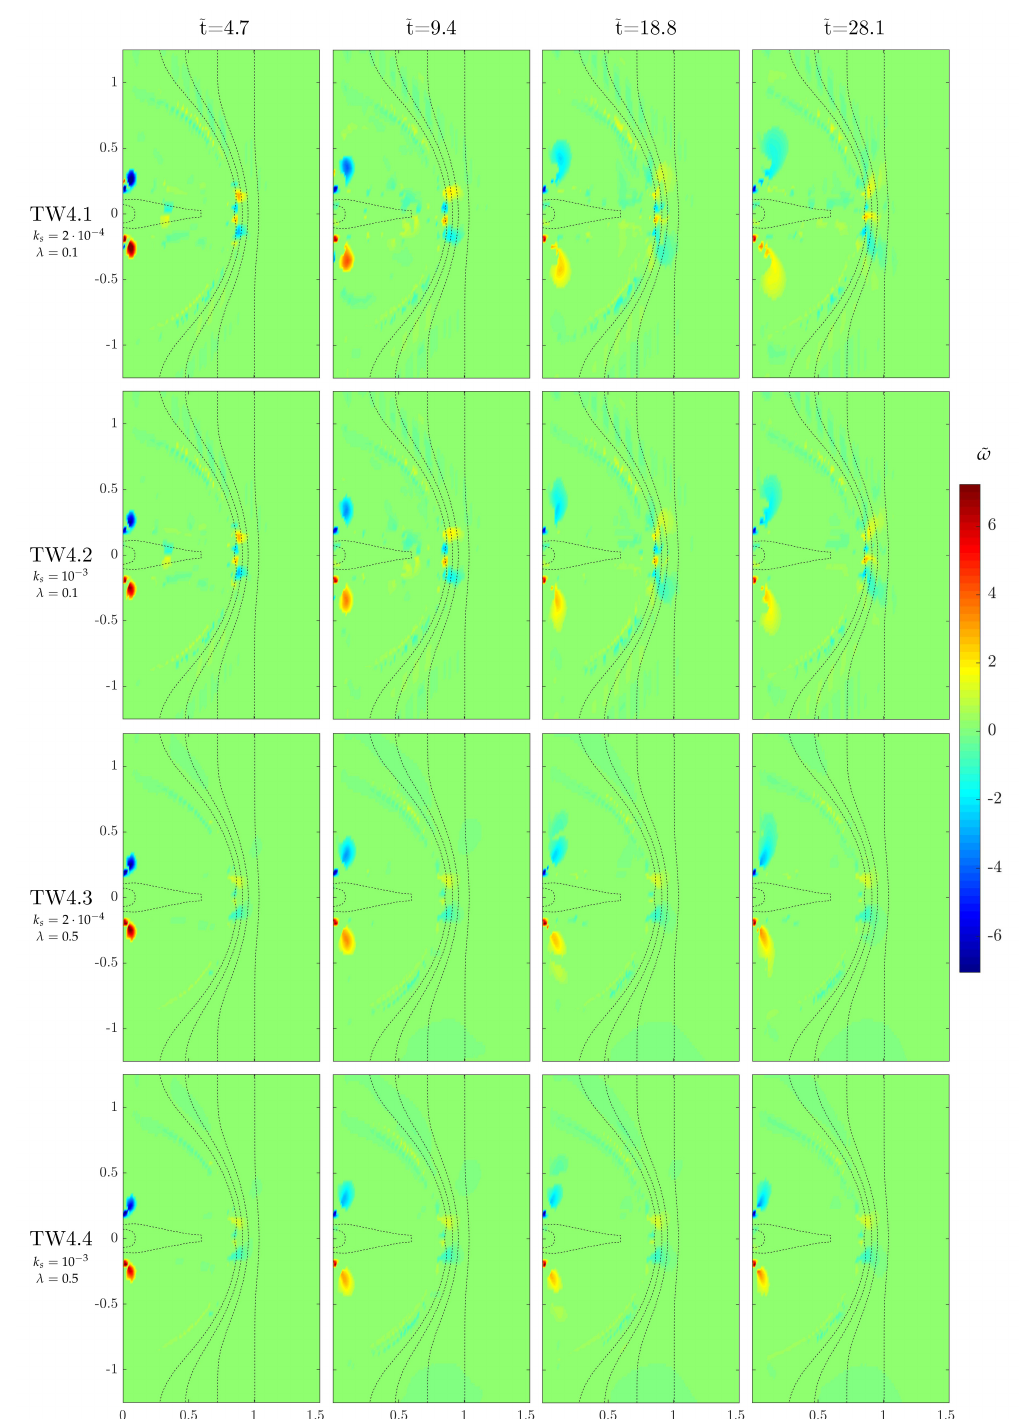
Figure 11. Time evolution of vorticity for test TW4 as a function of the intensity of friction and viscosity. The adopted values for the bed roughness k s and the eddy viscosity calibration parameter λ are given along with each test name. Each column represents a single time level (from left to right: ˜ t = 4.7, 9.4, 18.8, and 28.1). Red tones represent clockwise vorticity; blue tones represent anticlockwise vorticity. The dotted lines show the bathymetry contours of the shoal edge and the main